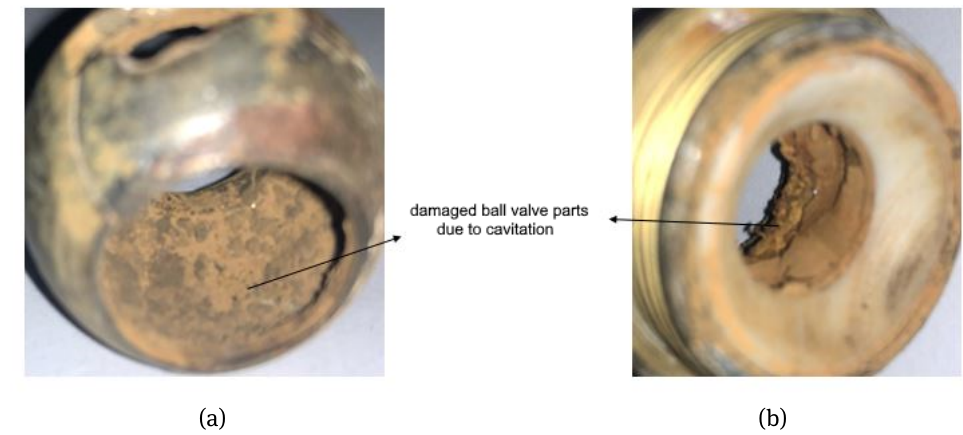
Figure 6: Damaged parts of the ball valve due to cavitation. (a) – Internal view of the eroded ball (b) – eroded valve end